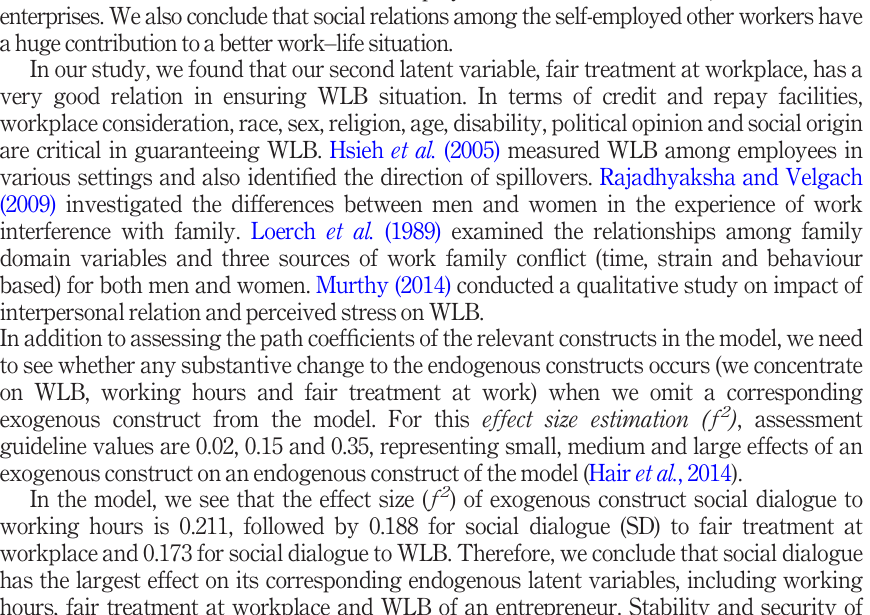
R 2 values are shown inside the circle (indicator) Connections and their respective path coef fi cients are shown below with t- values inside the parenthesis: Social dialogue (SD) to Work – life balance